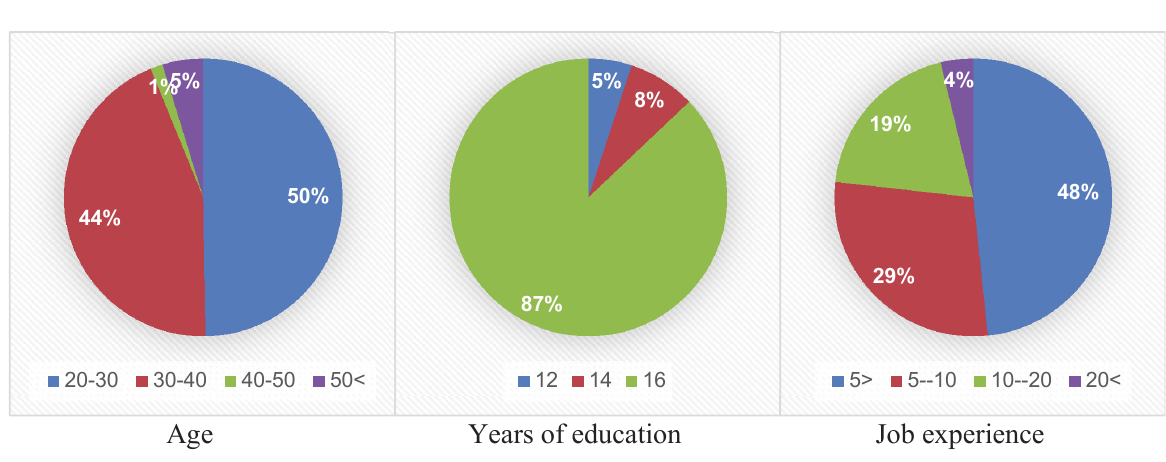
Fig. 1. Personal characteristics of the participants Descriptive statistics for research variables and Kolmogorov-Smirnov test Variable Mean Standard deviation Kolmogorov-Smirnov statistic